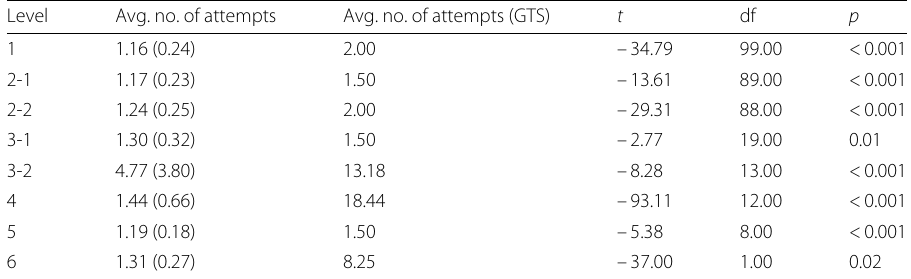
Table 3 One sample t test results comparing measured number of attempts per problem to the equivalent “gaming the system” calculated value. sd stands for standard deviation Level Avg. no. of attempts Avg. no. of attempts